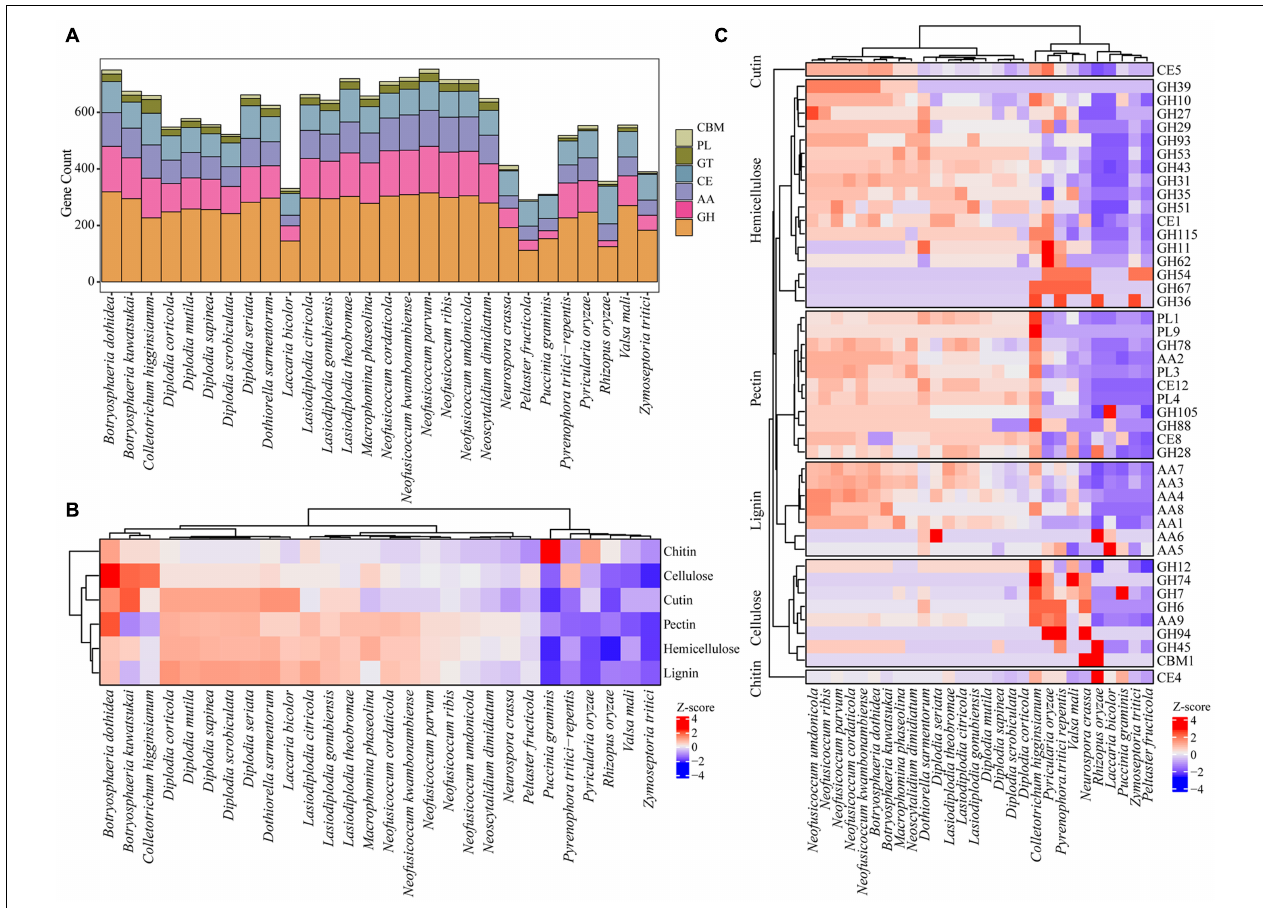
FIGURE 6 | Comparing CAZy among Botryosphaeriaceae fungi and other 10 fungal species. (A) Six CAZy classes: CBMs, Carbohydrate-Binding Modules; PLs, Polysaccharide Lyases; GTs, Glycosyl Transferases; CEs, Carbohydrate Esterases; AAs, Auxiliary Activities; GHs, Glycoside Hydrolases. (B) Distribution of CAZy related to cellulose, hemicellulose and lignin degradation. (C) Comparison of selected enzymes involved in PCW (plant cell wall) degradation among Botryosphaeriaceae fungi and other 10 fungal species. In heatmaps, Z-score were used to describe over-represented (+ 4–0) and down-represented (0 to − 4) gene